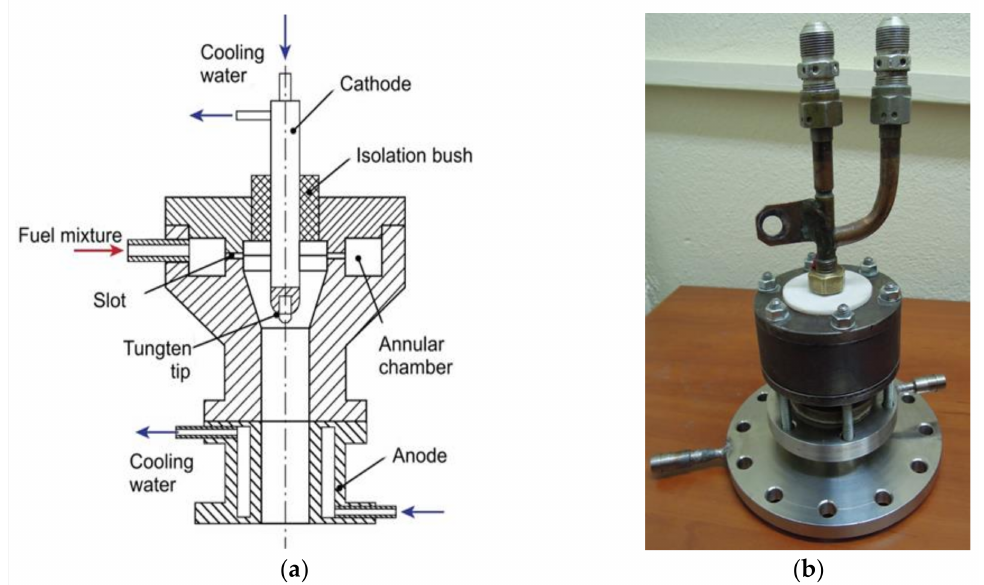
Figure 3. The plasma discharge chamber: ( a ) Discharge unit of the plasma converter; ( b ) assembled chamber with the cathode on top with the cooling water ports. The fuel mixture inlet is on the backside of the